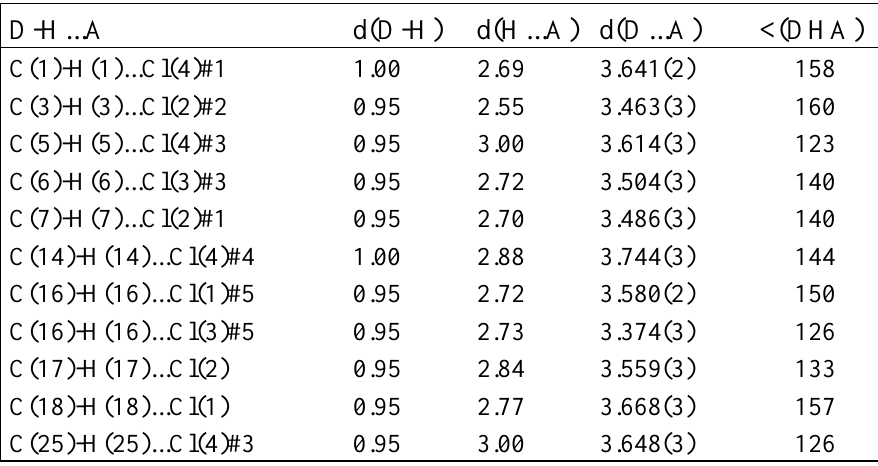
Table 4. Hydrogen bonds for 2R [Å and